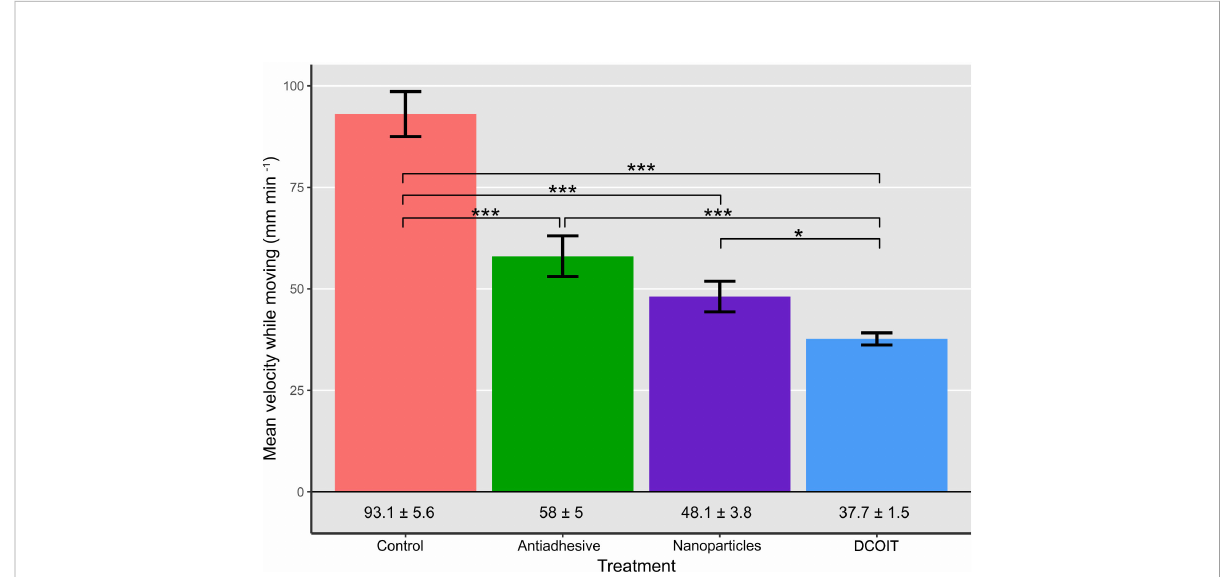
FIGURE 3 Average larval swimming velocity (mm min -1 ) in each treatment and control (n = 32 larvae per treatment). Numbers below bars indicate mean velocity ± SE in the corresponding treatment. Error bars represent SEM. Asterisks indicate statistically signi fi cant differences based on pairwise post-hoc tests with estimated marginal means (Supplementary Tables 1, 3; *p< 0.05, **p< 0.01, ***p<